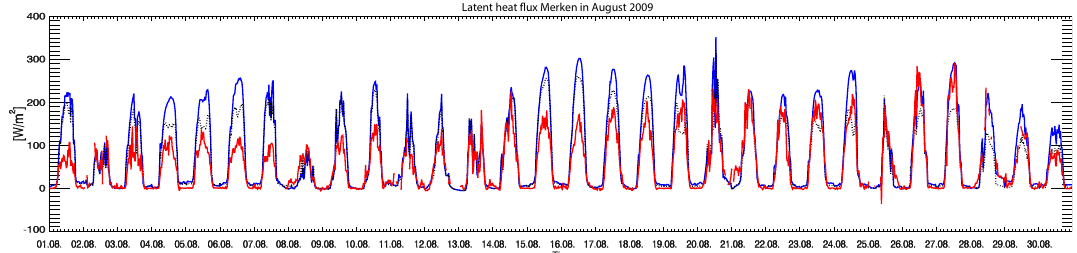
Figure 9. Surface latent heat flux in Merken in August 2009. Colours are as in Fig.